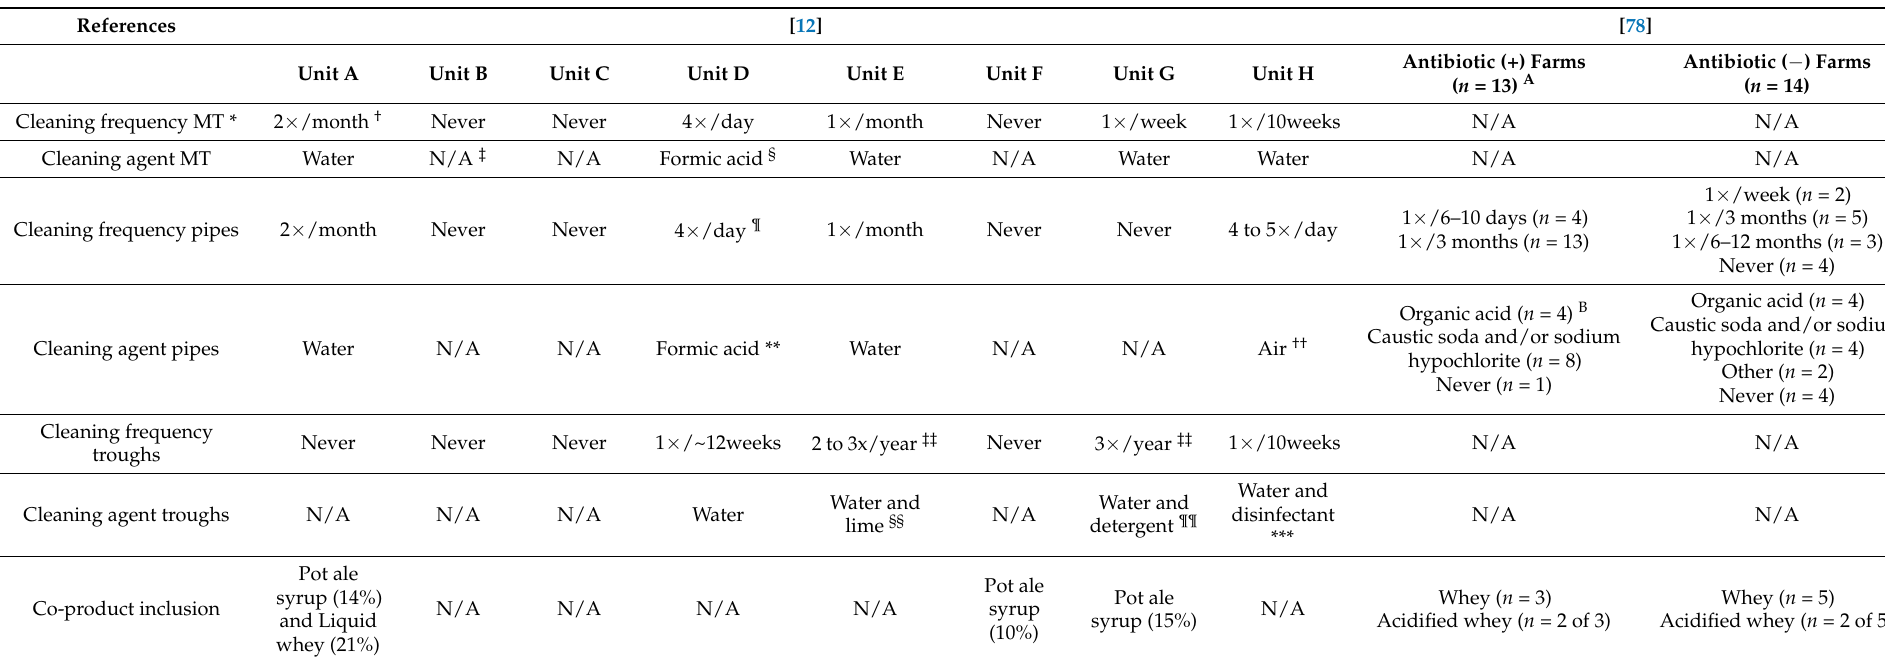
Table 5. Liquid feed system cleaning and sanitisation regimes and dietary co-product inclusion for finisher feed on eight Irish, and 27 Swiss pig